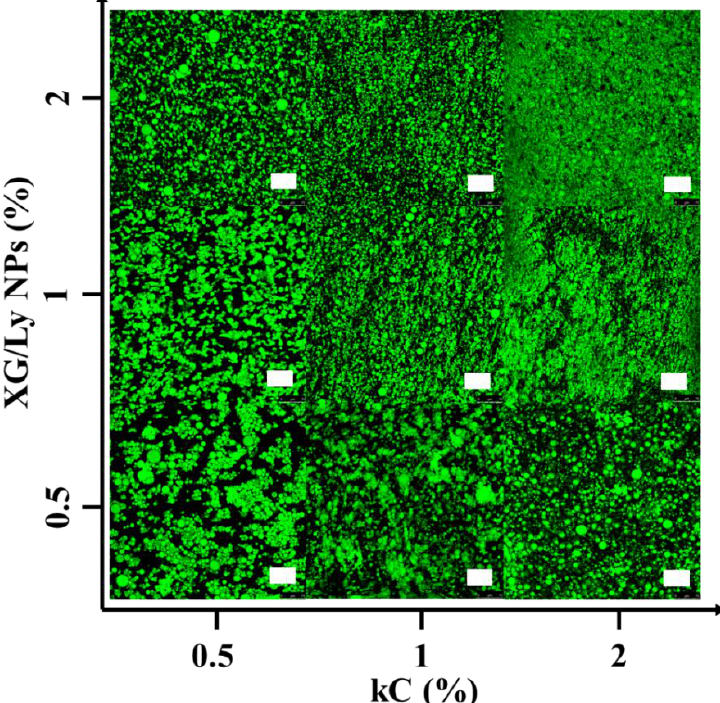
Figure 2. CLSM images of Pickering emulsion gel stained by Nile red prepared, scale bar 75μm.